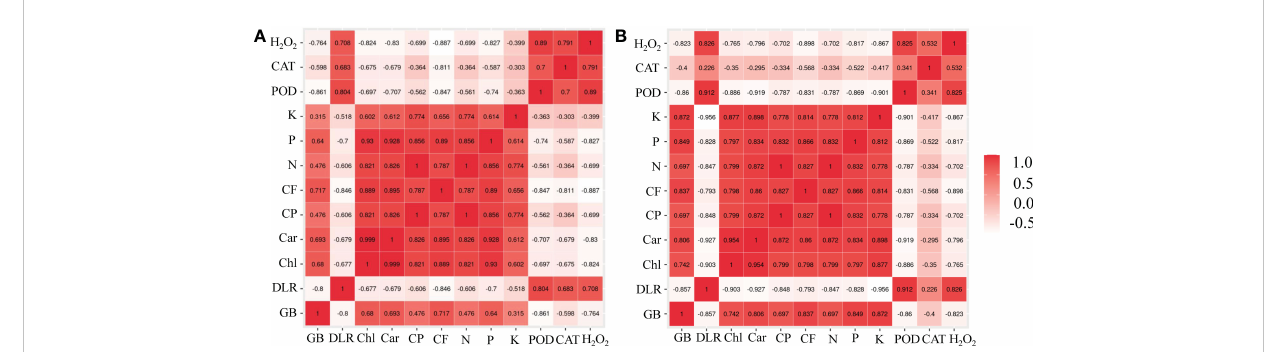
FIGURE 6 Correlation plot designed by the R software for all measured traits in bermudagrass under K de fi ciency (A) and P de fi ciency stress (B) . In the plots, red, pink, and white represent positive, zero, and negative correlations, respectively, and the darker the color (either red or white), the stronger the correlation. GB, growth biomass; DLR, dead leaf rate; Chl, chlorophyll a+b; Car, carotenoid; CP, crude protein; CF, crude fat; N, N content; P, P content; K, K content; POD, peroxidase; CAT, catalase; H 2 O 2 , hydrogen